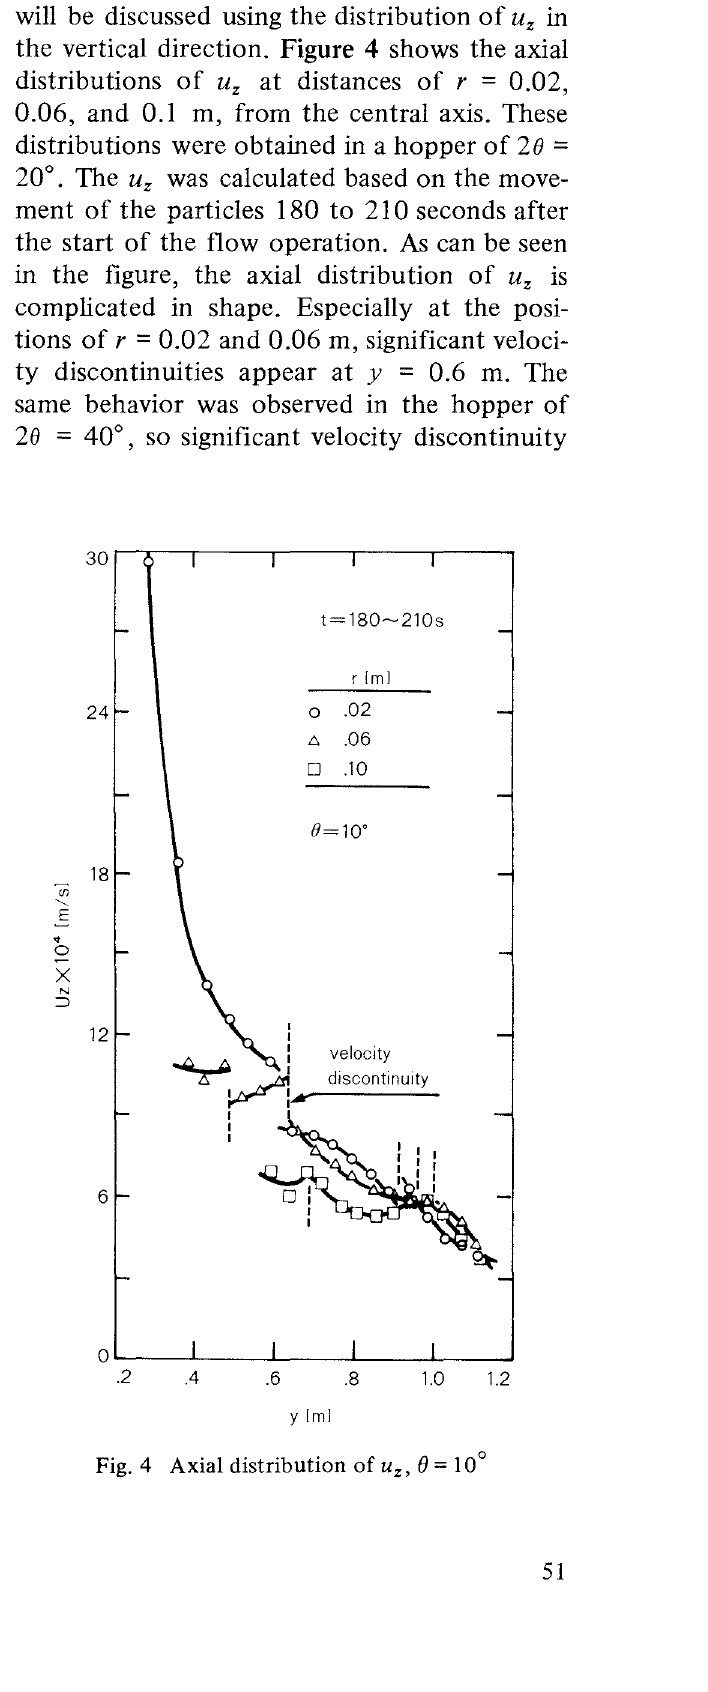
Fig. 4 Axial distribution of Uz,